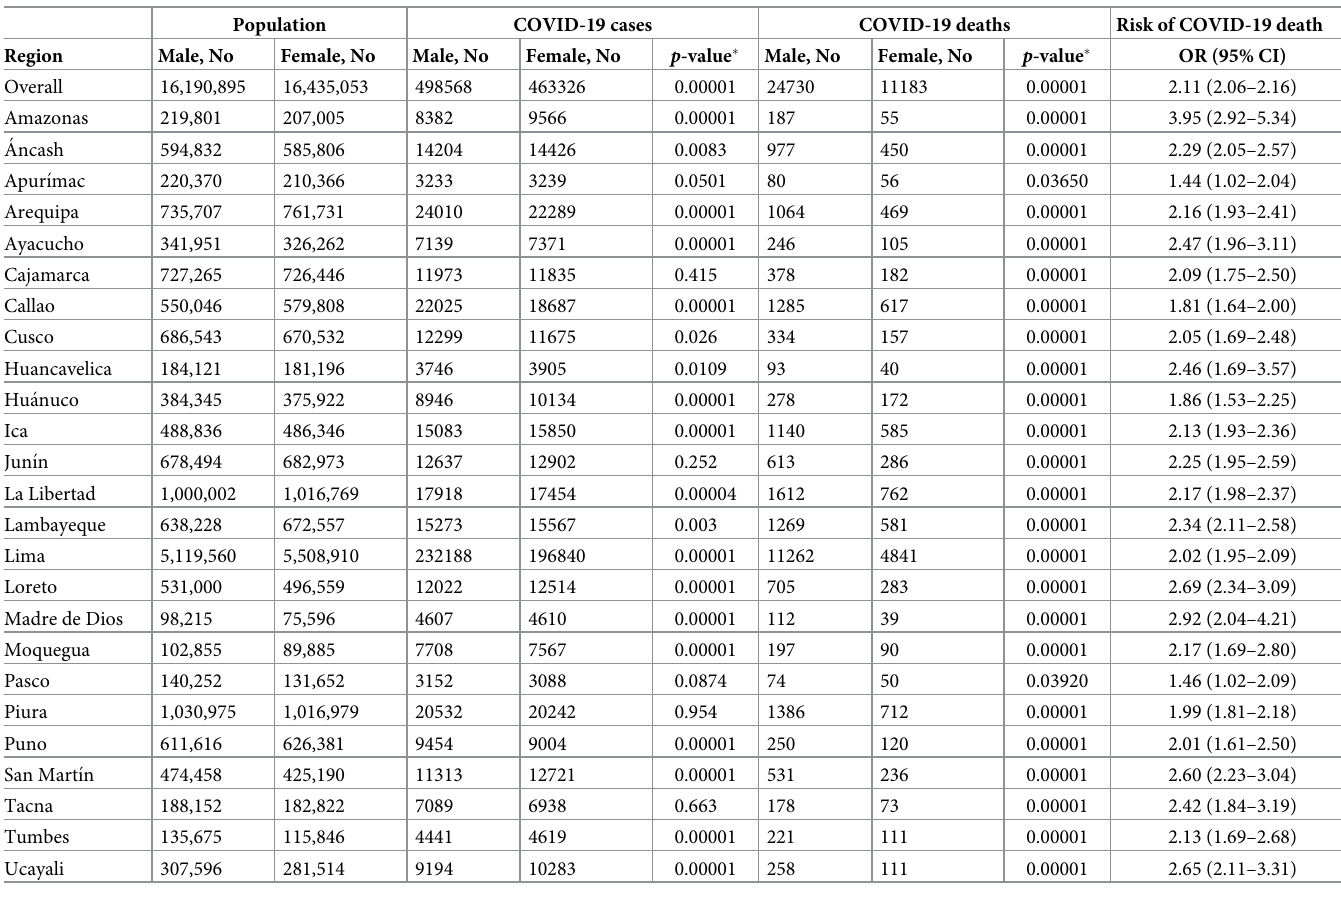
Table 1. Differences in the cases absolute numbers and risk of COVID-19 deaths, stratified by sex, and geographic distribution, Peru, 2020.